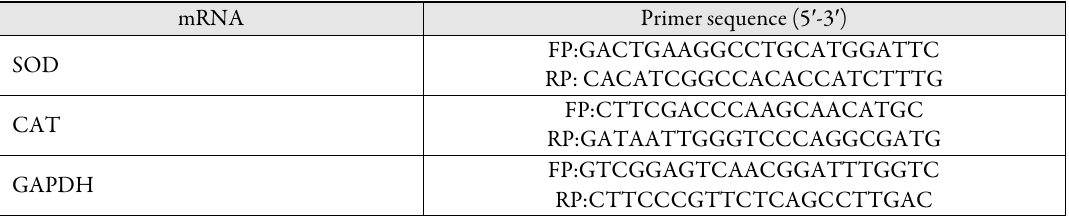
Table 1. Primer Pairs for